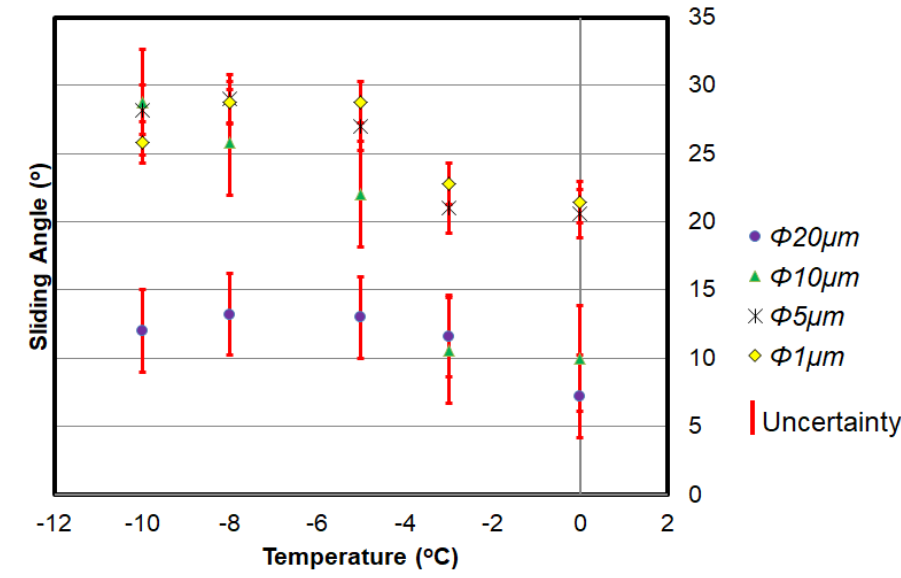
Figure 8. Dynamic-evaluation results related to the